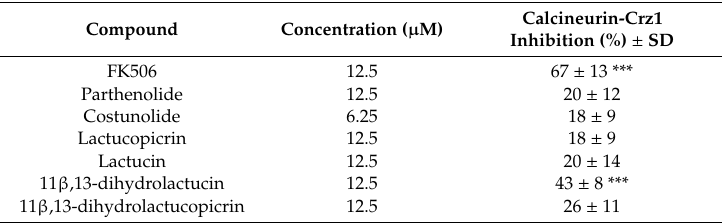
Table 5. Inhibition of calcineurin-Crz1 pathway by di ff erent SLs.